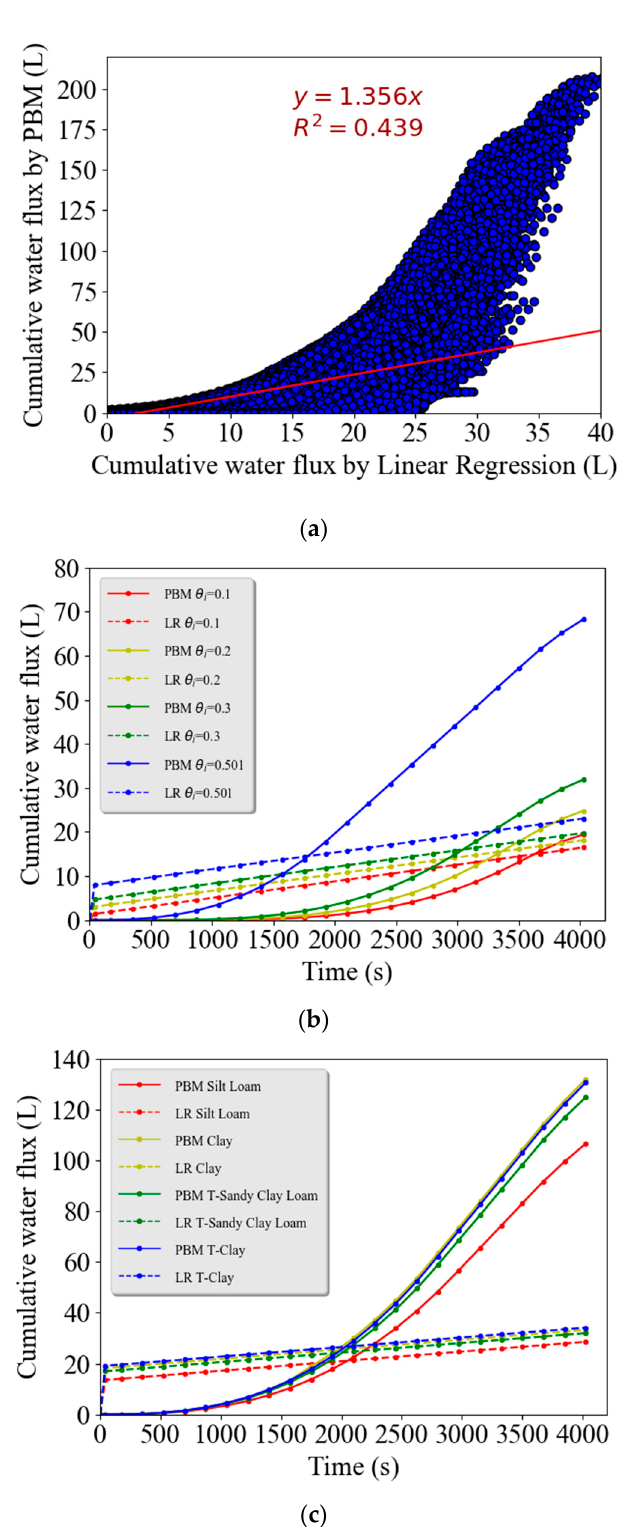
Figure 3. Comparison of cumulative water fluxes ( Q c in liters, L) calculated by the physically-based models PBM and the Linear Regression (LR) model (( a ) overall, ( b ) different initial water contents, ( c ) different textures)).